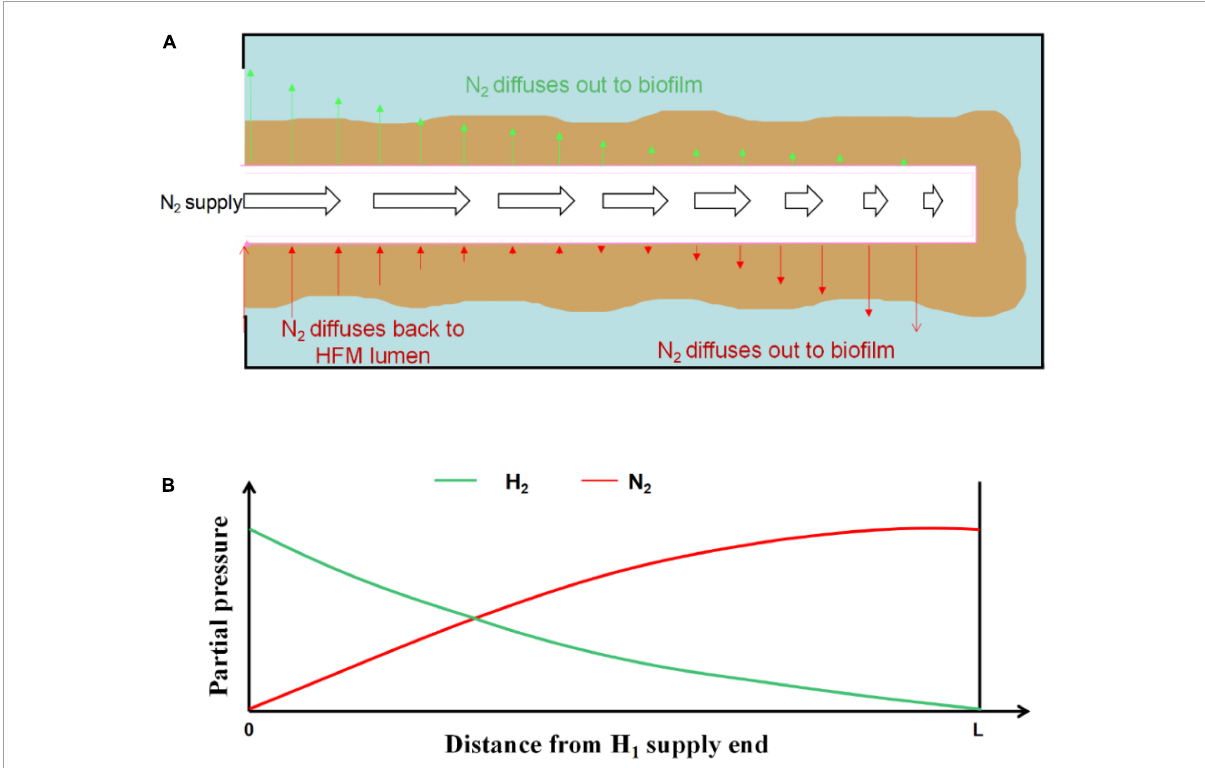
FIGURE2 Pressurized H 2 supply and N 2 back diffusion in a sealed end hollow fiber membrane (HFM): (A) Schematic of a single HFM with biofilm attached; (B) H 2 and N 2 partial pressure in the HFM lumen.